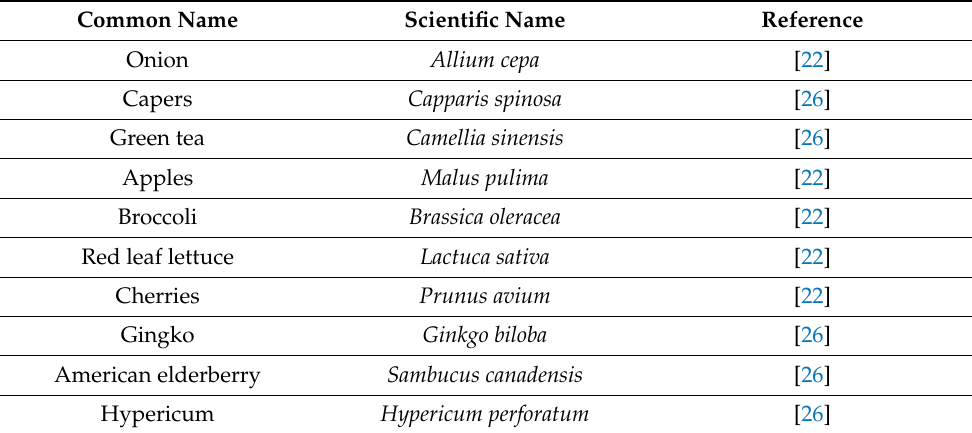
Table 1. Common sources of quercetin.